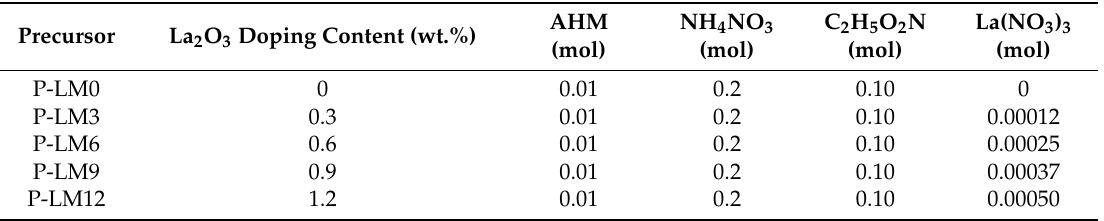
Table 1. Amount of raw materials used for the solution combustion synthesis (SCS) of La 2 O 3 doped MoO 2 precursors.